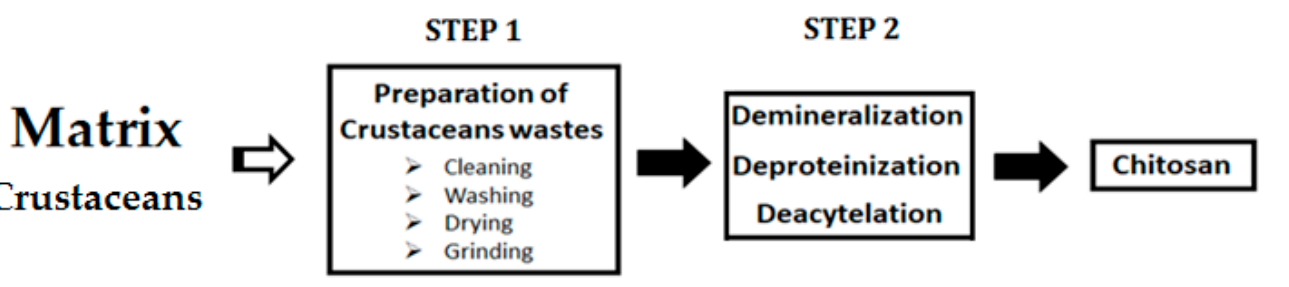
Figure 3. Process of chitosan